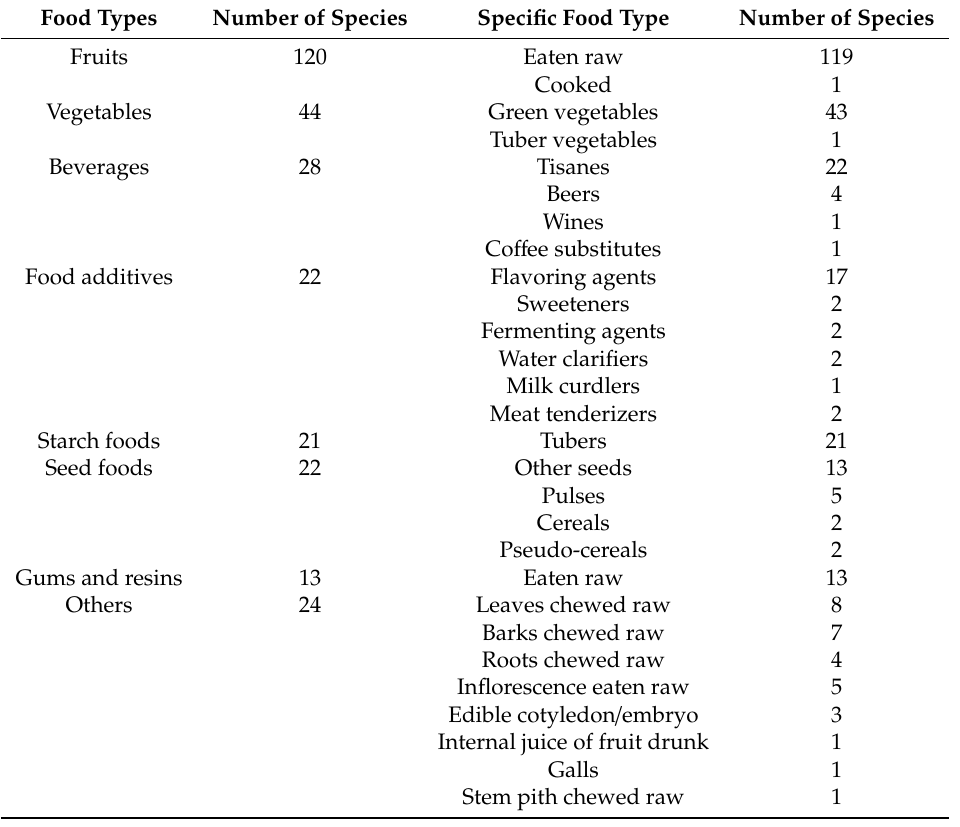
Table 2. Classification of food types and the number of species in each